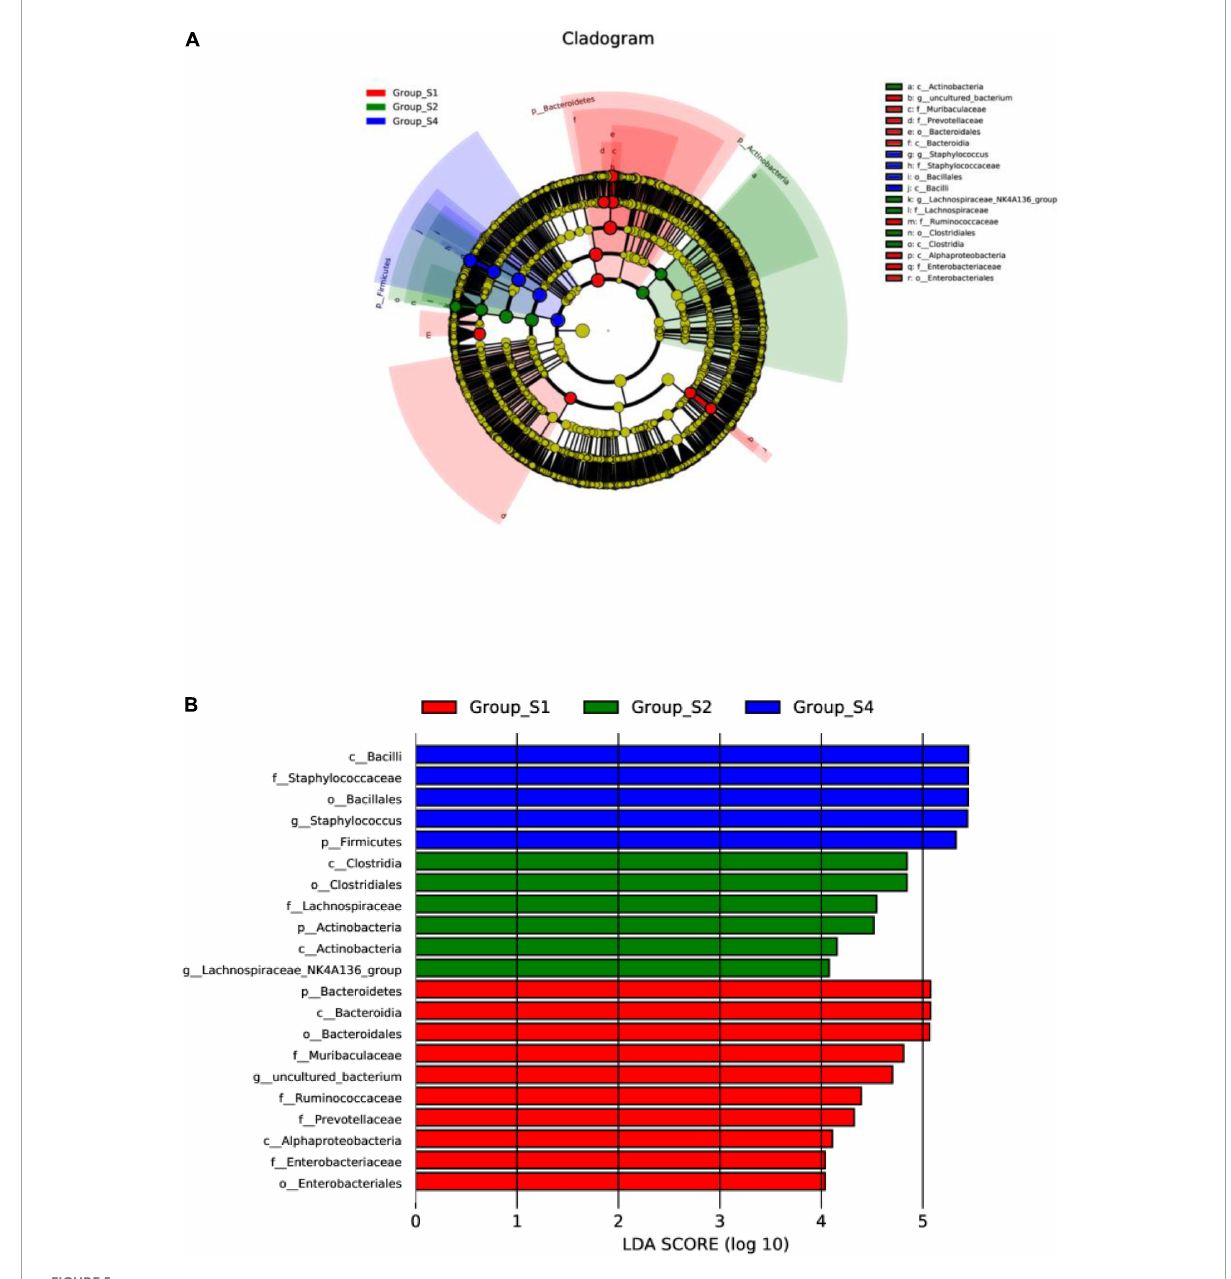
FIGURE5 LEfSe highlights consistently differentia bacteria taxa of fermented mutton sausage during natural ripening within four stages. (A) Cladogram representation; (B) the predominant bacteria of the microbiota, LDA score is over 4. Labels beginning with o_indicate order; f_family; g_genus;